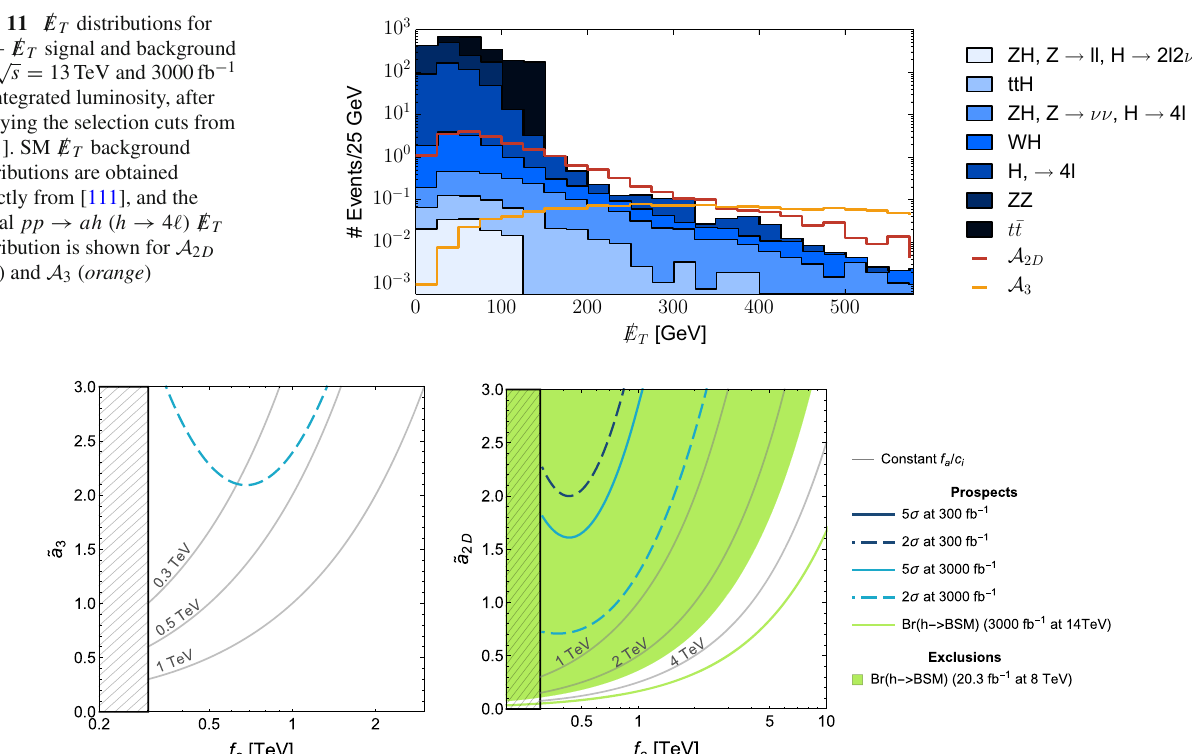
Fig. 12 Contours for (cid:2) σ = 2 ( dashed ) and (cid:2) σ = 5 ( solid ) sensitivity to region corresponds to f a < 2 / E min T , and is excluded by the EFT valid- √ s = 13TeV and for an integrated mono-H signal at the LHC with ity, while the green region is excluded by the bound on Br ( h → BSM ) luminosity of 300fb − 1 ( dark blue ) and 3000fb − 1 ( light blue ), as a reported in Eq. (76) (for the left panel , this bound is not visible). The grey reference lines correspond to constant values of f a / c function of { f a , c i } . The left ( right ) panel shows the results obtained assuming that only the operator A 3 ( A 2 D ) is contributing. The hatched